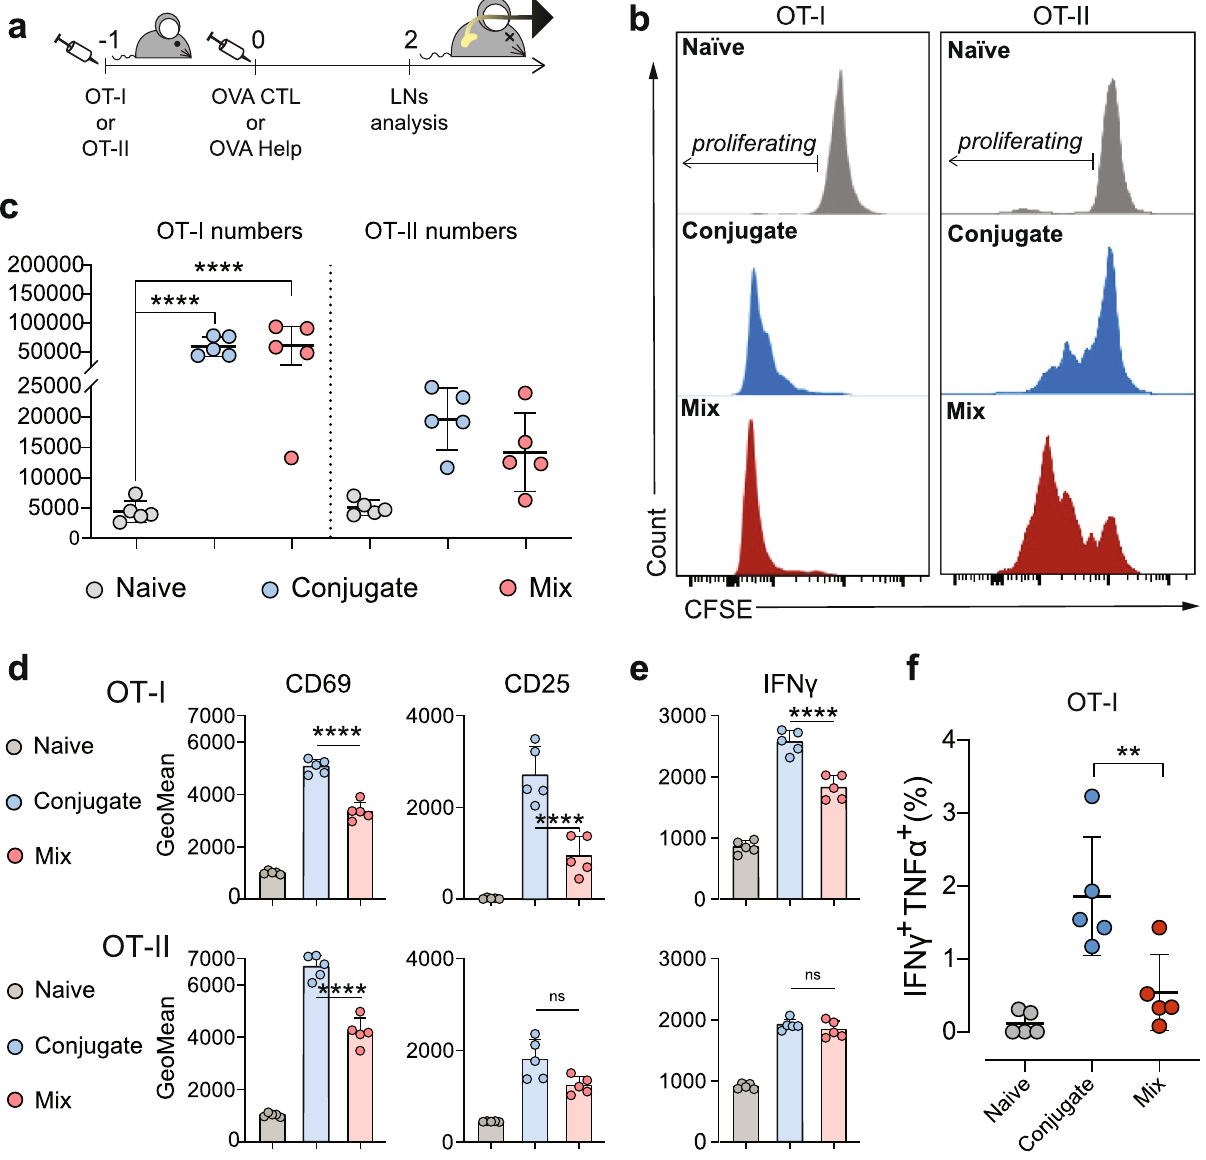
Fig. 3 OVA CTL and Help Lipid A-peptide conjugates promote enhanced activation of T cells upon in vivo injection. a Mice ( n = 5 per group) were adoptively transferred with CFSE labeled OT-I or OT-II cells 24 h before intradermally receiving 2 nmol of OVA CTL or Help CRX- 527conjugates, or an equimolar mix of peptide and CRX-527. 48 h later, the inguinal lymph nodes were harvested for analysis of OT-I or OT-II T cell proliferation and activation. b Representative histograms of CFSE signal in labeled OT-I or OT-II cells. c Absolute count of total OT-I and OT- II cells in pooled inguinal lymph nodes. d Mean fl uorescence intensity (GeoMean) of CD69 and CD25 T cell activation markers in OT-I (upper) or OT-II (lower) cells as detected by fl ow cytometry. e Mean fl uorescence intensity of IFN γ cytokine in OT-I (upper) or OT-II (lower) as detected by fl ow cytometry. Statistical signi fi cance of the conjugates compared to the mix in both ( d ) and ( e ) was determined by one-way ANOVA followed by Sidak ’ s multiple comparison test; ***** p < 0.0001. f Percentage of IFN γ /TNF α double producing OT-I cells. Statistical signi fi cance was determined by one-way ANOVA followed by Tukey ’ s multiple comparison test; ** p < 0.01, all data are displayed as mean ± peptides displayed a signi fi cant expansion of SIINFEKL vaccinated with the T-helper conjugate or the mixture (Fig. 4b, responses after tumor injection. Notably, the mice that received left panels). These responses were not detected in unvaccinated the conjugated vaccine displayed the highest frequencies (up to mice and can be attributed to the presence of tumor-speci fi c T- 5%) of total CD8 T cells of all groups (Fig. 4b, right panel). The helper responses, which facilitated tumor-induced priming of ability of these responses to immunologically protect mice from SIINFEKL-speci fi c responses. In the groups that were vaccinated tumor growth was evaluated by following tumor sizes over with the CTL epitope, the levels of SIINFEKL-speci fi c responses 60 days (Fig. 4c). All unvaccinated mice developed a tumor were detectable on the day of tumor challenge and one week within 20 days. Mice vaccinated with the CRX-527-T-helper after. The groups that received only CTL peptide did not show conjugated or unconjugated vaccine experienced a short delay any tumor-speci fi c expansion or decrease of the SIINFEKL- in tumor growth (Fig. 4c, left panel) which was more speci fi c response (Fig. 4b, middle panel). In contrast, the groups pronounced in the mice that received the conjugate vaccine vaccinated with the combination of the CTL and T-helper